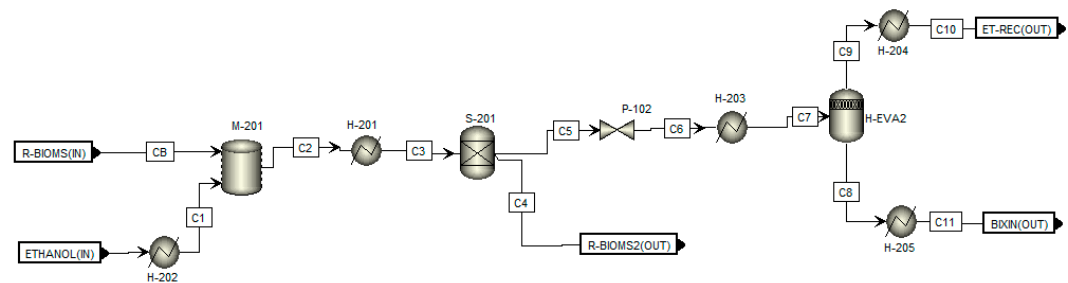
Figure A4. Flowchart of the low-pressure solvent extraction (LPSE) process for obtaining bixin-rich extract from annatto seeds developed in Aspen Plus ® .